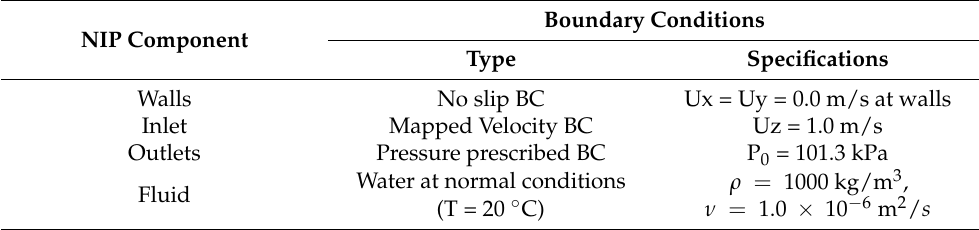
Table 2. Mathematical model boundary conditions and fluid thermophysical